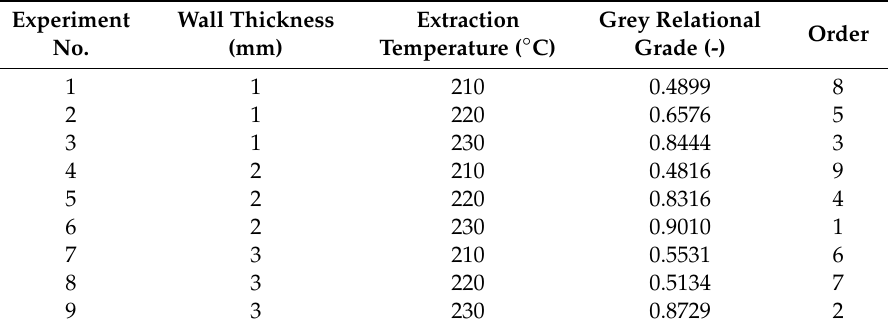
Table 12. Grey relational grade